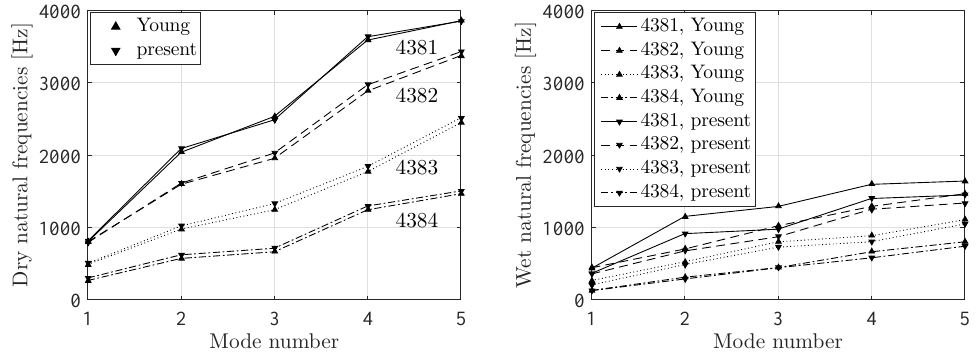
Figure 5. Comparison of dry ( left ) and wet ( right ) natural frequencies of the Boswell propeller blades from Young [7] and present